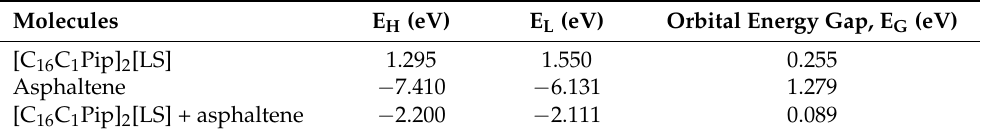
Figure 15. ( a ) HOMO location of [C 16 C 1 Pip] 2 [LS] + asphaltene model. Yellow, blue, grey, white and red respectively, represented sulfur, nitrogen, carbon, hydrogen and oxygen. ( b ) LUMO location of [C 16 C 1 Pip] 2 [LS] + asphaltene model. Table 6. HOMO (E H ) and LUMO (E L ) energies for [C 16 C 1 Pip] 2 [LS], asphaltene and [C 16 C 1 Pip] 2 [LS] with